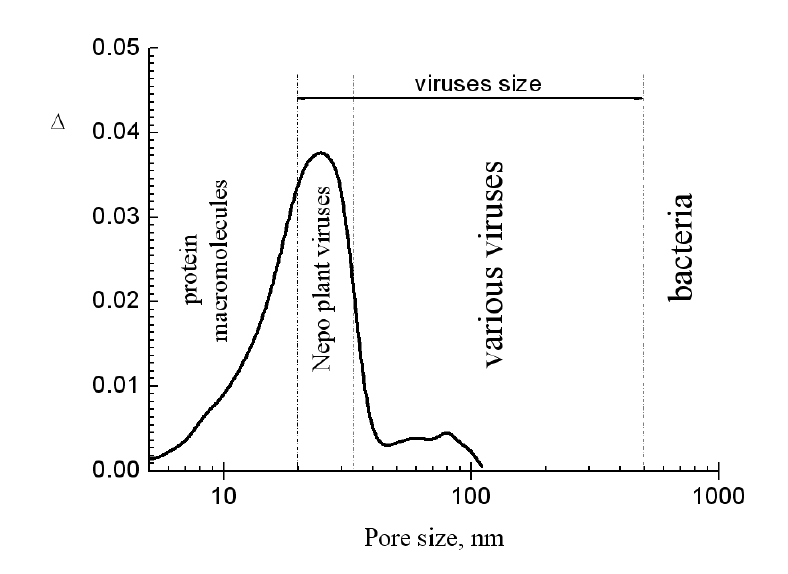
Figure 3. Pore size distribution of the MesoPS sensors and characteristic sizes of viruses, bacteria, and protein